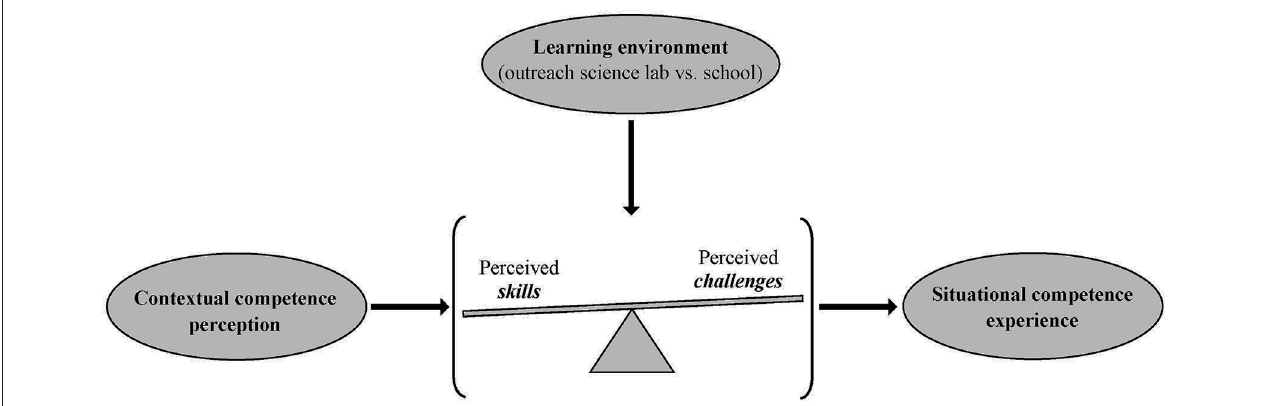
FIGURE 1 | The moderating effect of the learning environment on the interrelationship of contextual competence perception and situational competence experience.